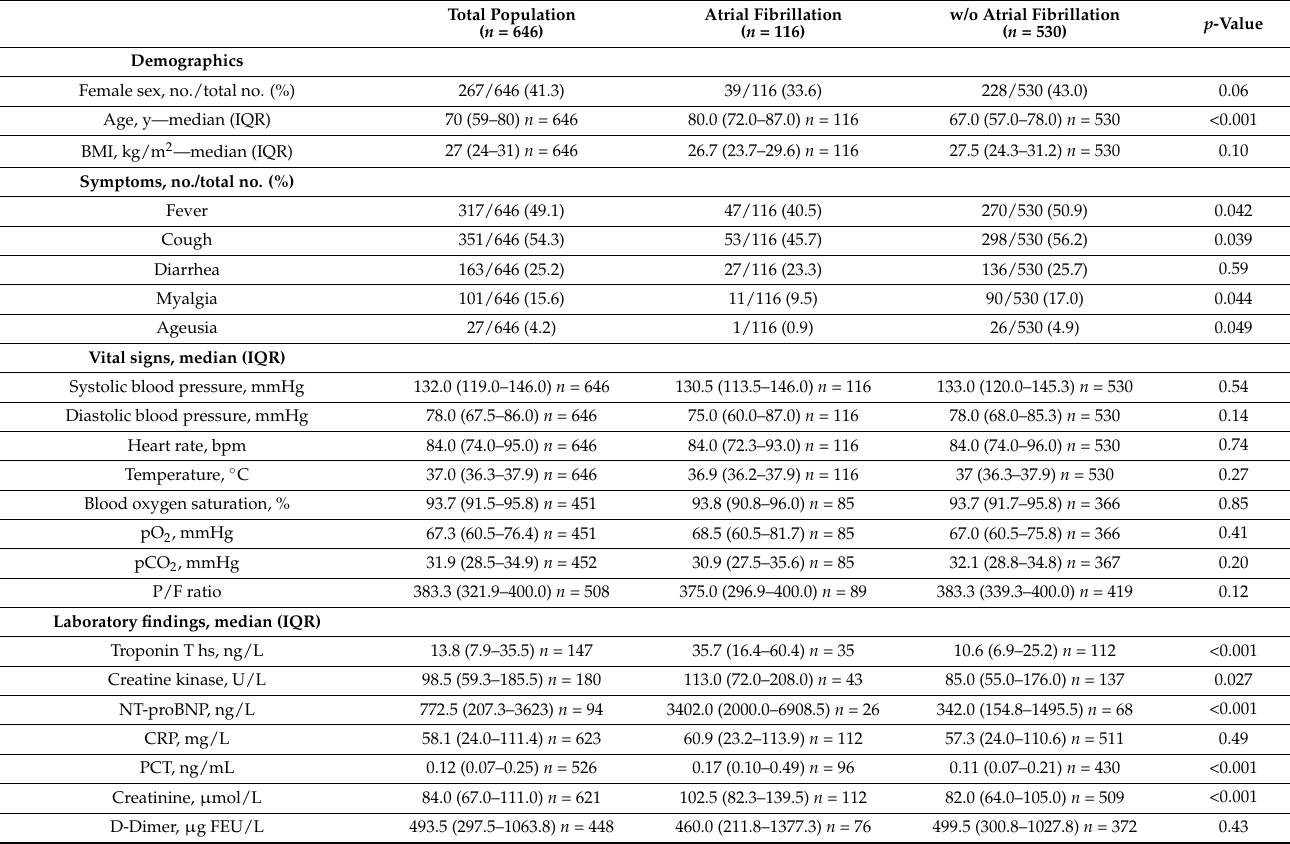
Table 1. Characteristics of COVID-19 Patients with and without Atrial Fibrillation. Total Population Atrial Fibrillation ( n = 646) ( n =